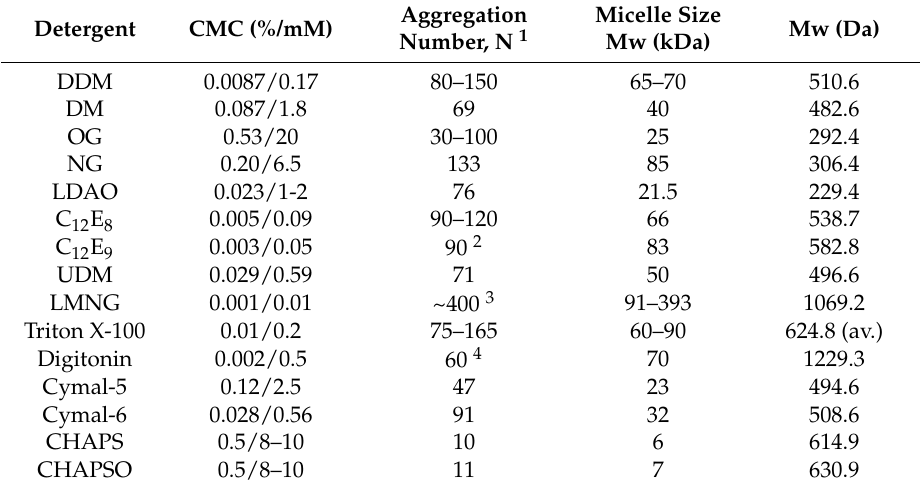
Table 1. The properties of the most commonly used